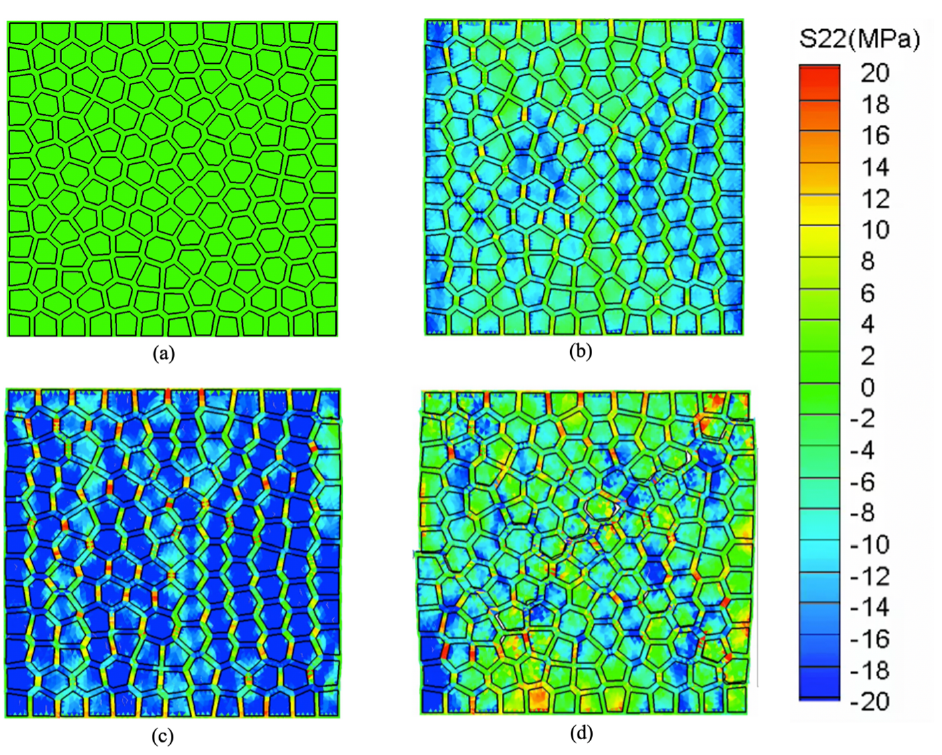
Figure 3. Snapshots of stress distribution ( σ 22 ) under impact loading: ( a ) initial stage; ( b ) stress concentration; ( c ) crack initiation; ( d ) crack coalescence.